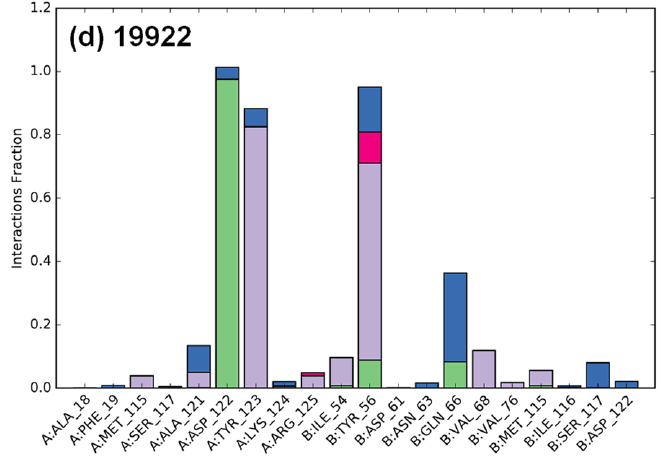
Figure 5. The protein interactions with the ligand (H-bonds, hydrophobic, ionic and water bridges) normalized over the course of the simulation. Our most active compound 1 (18532) exhibited strong interactions with two key amino acids (Tyr56 and Ala121).